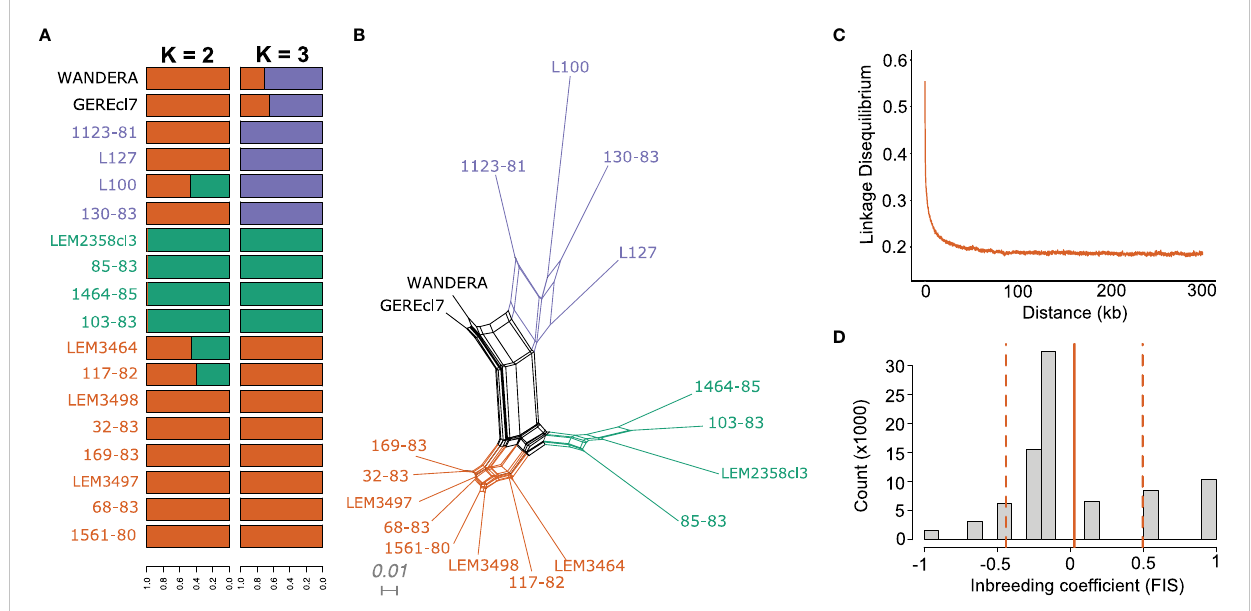
FIGURE 3 Population genomic diversity and structure of L. aethiopica . (A) Bar plots depicting ancestral components as inferred by ADMIXTURE for K = 2 and K = 3 populations, based on 85,725 SNPs. (B) Phylogenetic network based on uncorrected p-distances among 18 L. aethiopica genomes genotyped at 277,156 bi-allelic SNPs. Colored branches and tip labels correspond to the inferred populations by ADMIXTURE at K=3. (C) Linkage decay plot for 1561-80, 68-83, 169-83, 32-83 and 117-82 controlling for spatio-temporal Wahlund effects (see methods). (D) F is distribution after correction for spatio-temporal Wahlund effects for 1561-80, 68-83, 169-83, 32-83 and 117-82. The solid line represents the mean F is values (0.027) while the dashed lines represent the standard deviation (±